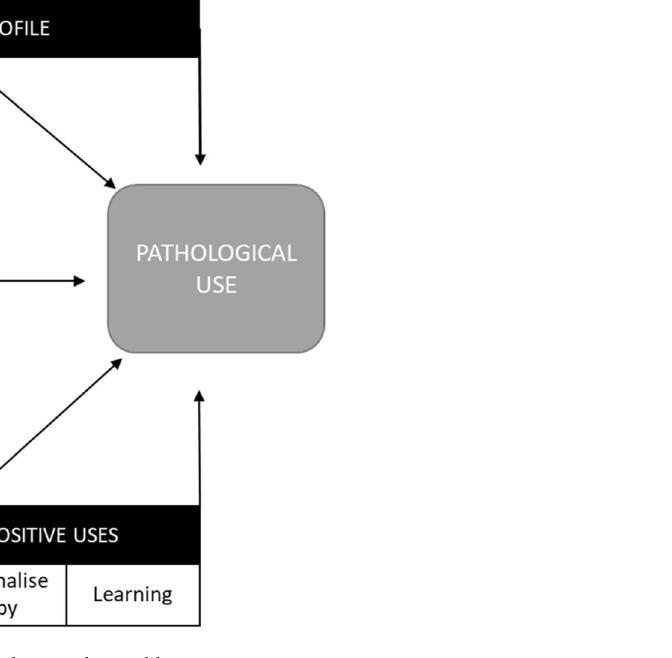
Figure 1. Summary of neural network